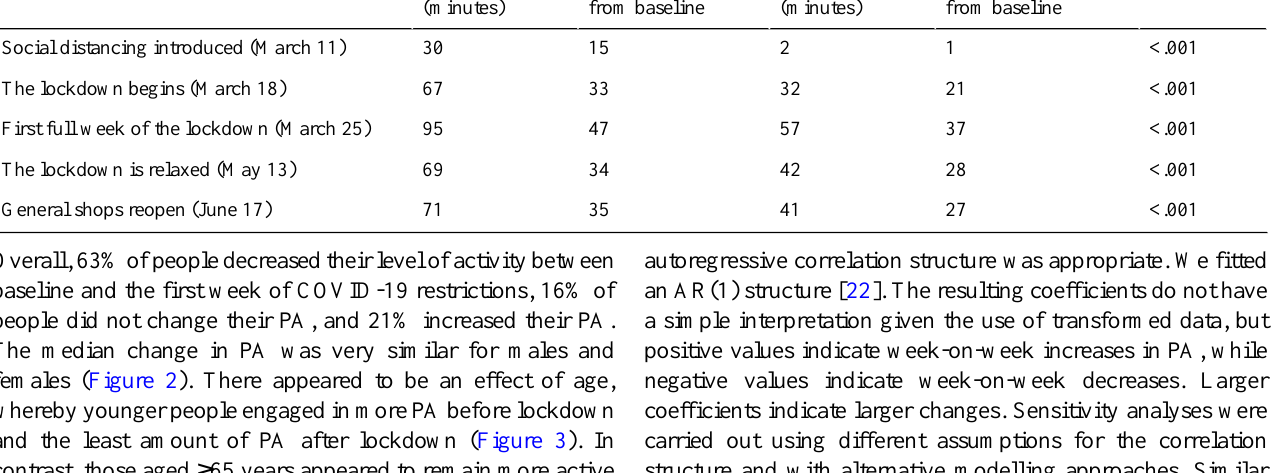
P valuePercentage